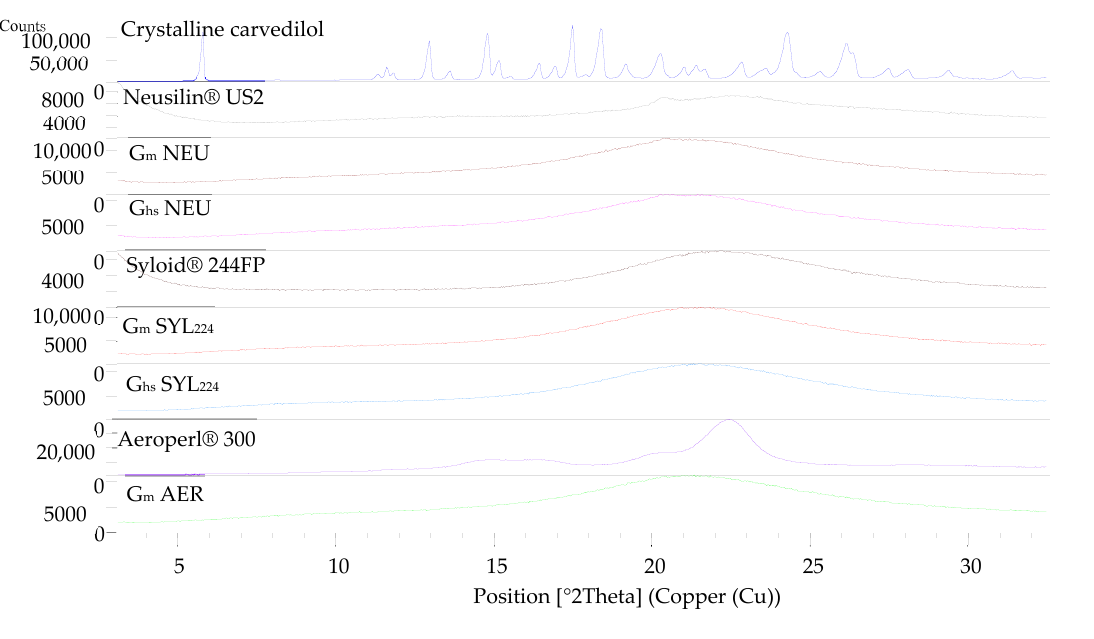
Figure 5. XRD diffractograms of pure crystalline carvedilol, three pure mesoporous carriers (Neusilin ® US2, Syloid ® 244FP and Aeroperl ® 300) and corresponding granules (G m NEU, G hs NEU, G m SYL 224 G hs SYL 224 , G m AER and G hs AER).